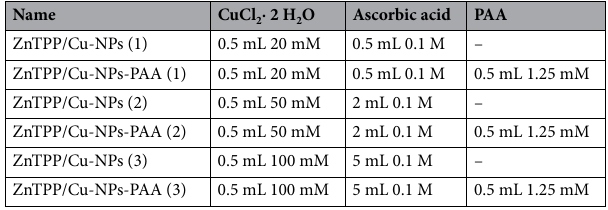
Table 1. Synthesized samples in various